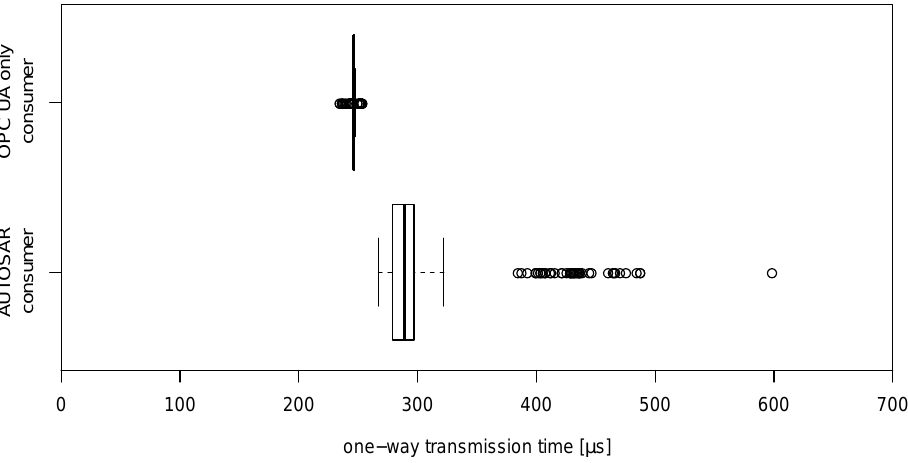
Figure 18. Distribution of end-to-end transmission times between a provider and a consumer application. Additionally, we verified the robustness of the setup with an endurance test of eight consecutive hours (28,800,000 messages). Again, the provider did not miss a time slot. Our changes in the information model memory management (alternating buffers for nodes) led us to test data integrity. By comparing the redundant timestamp copies within the event samples, we found that no sample was